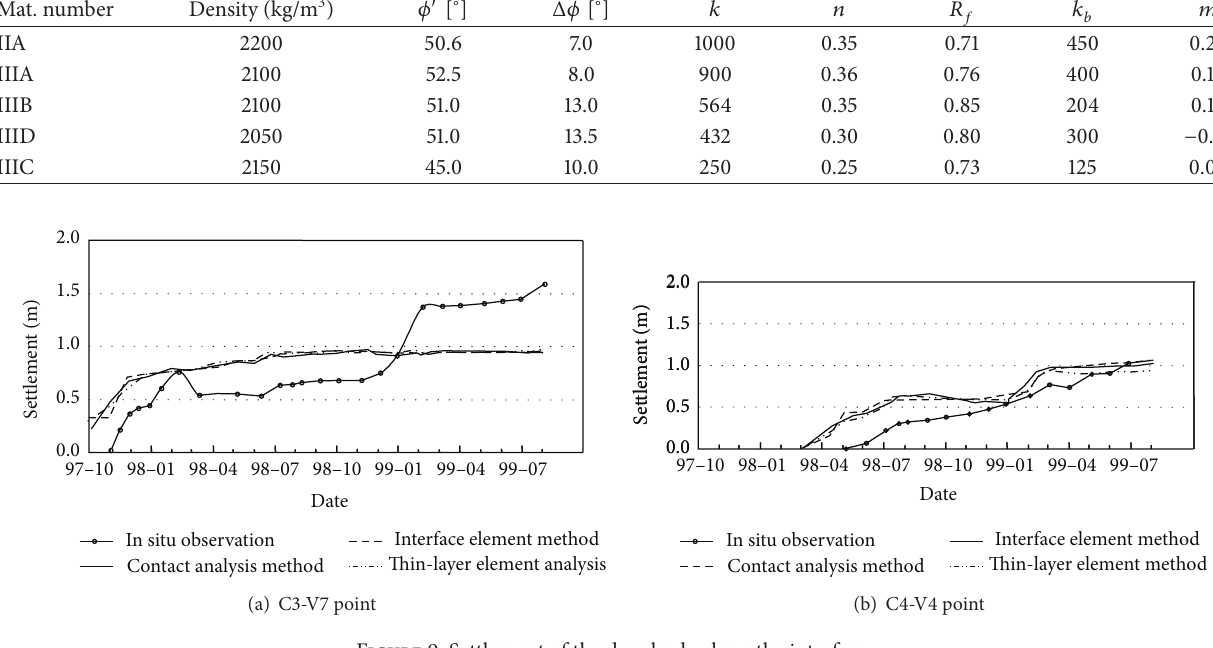
Figure 9: Settlement of the dam body along the interface.